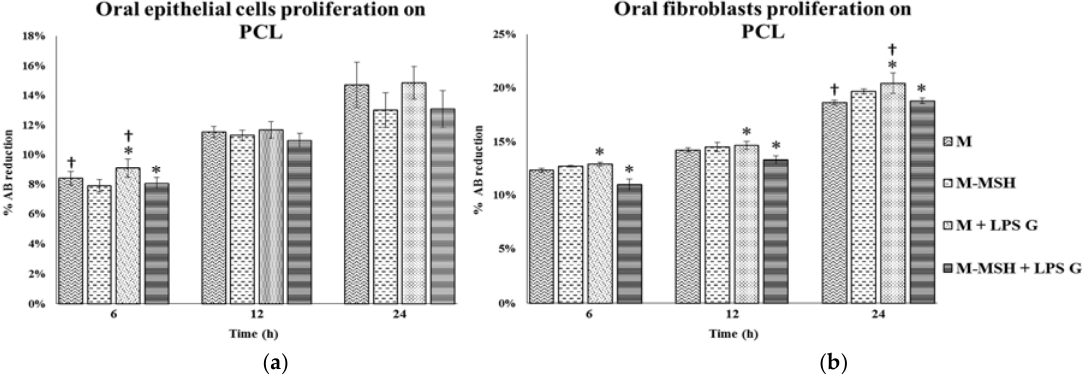
Figure 7. Human oral epithelial cells ( a ); and fibroblasts ( b ) proliferation with PCL membranes. Proliferation of human oral epithelial cells and fibroblasts were analyzed after 6, 12 and 24 h on PCL cultures ( n = 4). These different conditions have been measured by using AlamarBlue test. Data are expressed as mean ± SD; †: di ff erence between non ‐ stimulated and stimulated cells, p < 0.05; * : difference between stimulated cells with or without PGA ‐α‐ MSH, p < 0.05.